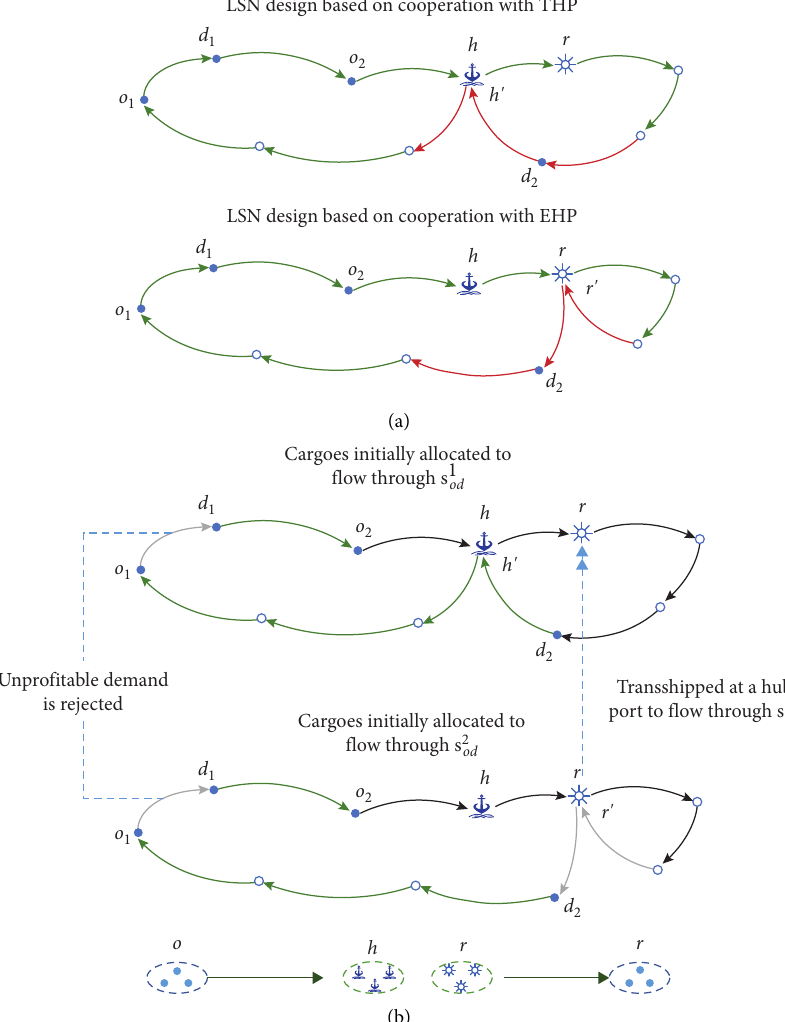
Figure 1: Two-phase decision-making process for merged shipping company. (a) The LSN design problem in the NA phase and (b) the LSN operation problem in the NO